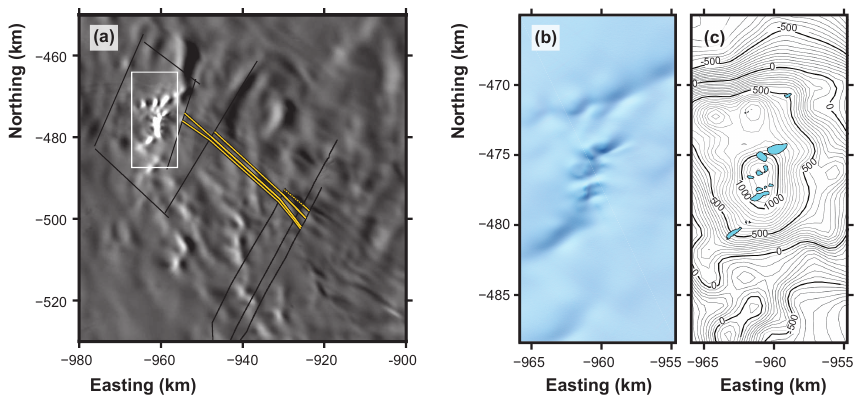
Figure 3. (a) MODIS imagery for the region (Haran et al., 2014), showing high reflectivity at the source of the unconformity over Mt. Resnik. Traces of slope-breaks in the unconformity are plotted in yellow. (b) False-color Landsat 8 imagery collected over Mt. Resnik, using the near infrared (band 5), green (band 3), and blue (band 2). (c) Contoured basal topography, with blue-ice areas (inferred from blue to near-infrared reflection intensity ratios > 2)